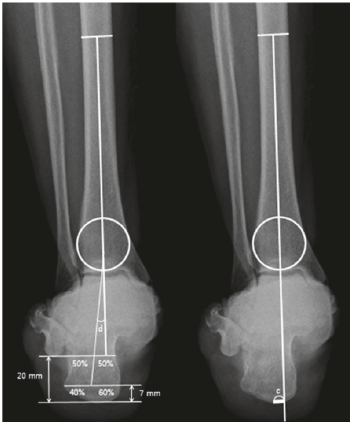
Figure 2: Heel alignment angle (HA) was defined as the angle (d) between the tibial axis and the calcaneal axis. Heel alignment distance (HD) was defined as the distance (c) between the contact point of the heel and the intersection of the extended tibial axis and the distal part of the calcaneus. Figure 2 is reproduced from Jeong et al. 2018 [7].